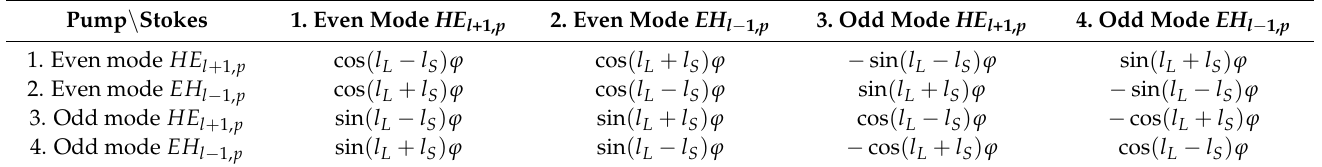
Table 1. The function f ( ϕ ) for different types of pump/Stokes modes used for SBS interaction. Pump \